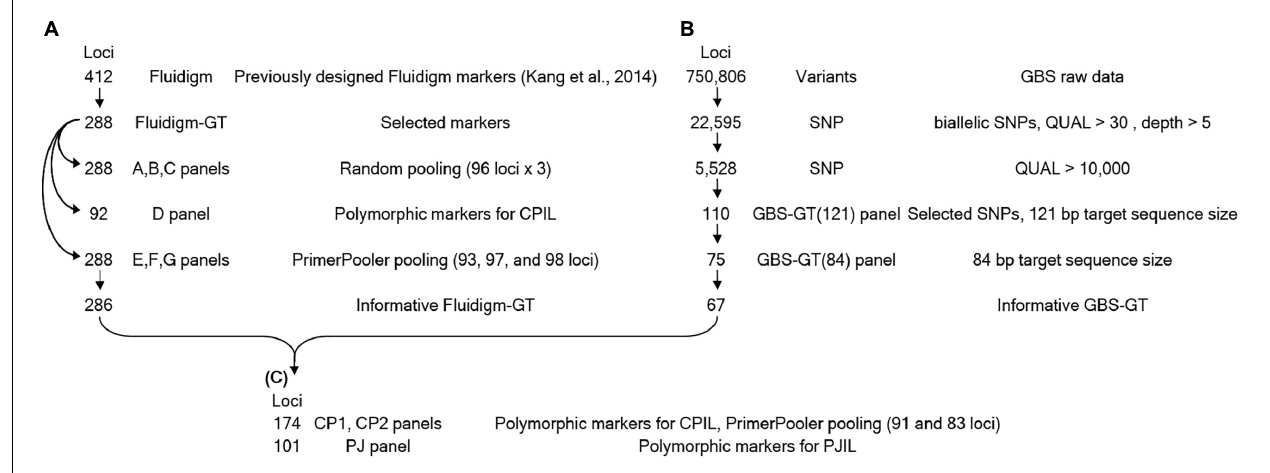
FIGURE 2 | Strategy for developing GT-seq panels. (A) The panels of Fluidigm-GT-seq primer converted from Fluidigm markers. (B) The panels of GBS-GT-seq primer designed from GBS-SNP. (C) The panels by mixing the Fluidigm-GT-seq and GBS-GT-seq